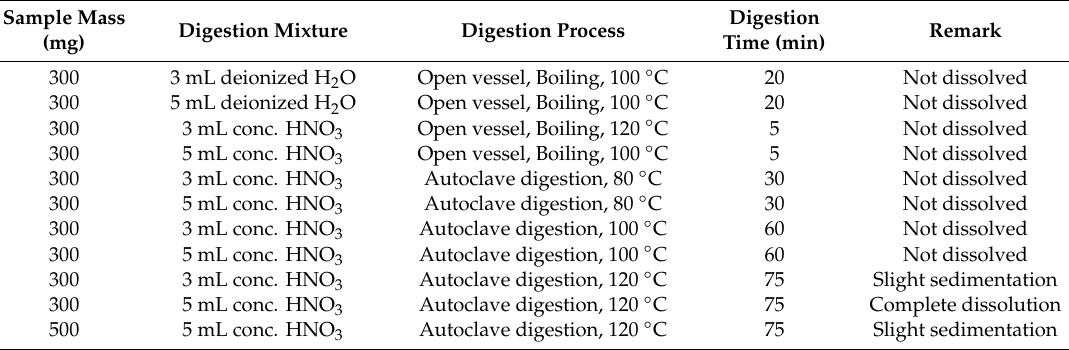
Table 2. Dissolution tests for the digestion of snack